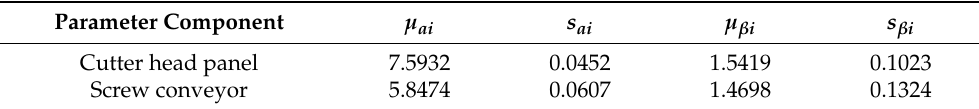
Table 10. Mean and variance for the cutter head panel and screw conveyor under the logistics distribution.